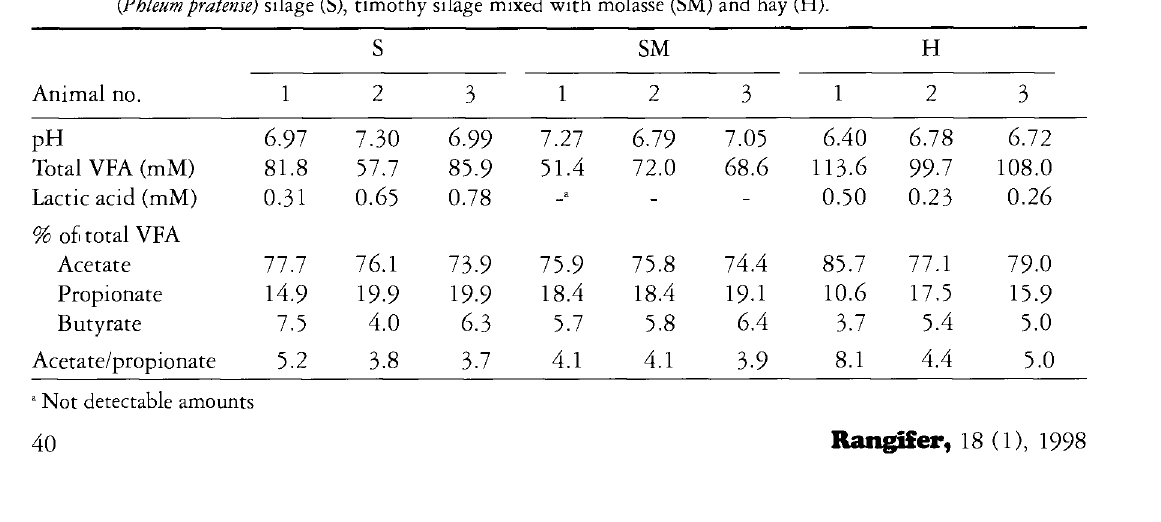
Table 3. Ruminal pH, concentration of volatile fatty acids (VFA) and lactic acid, and the relative proportion (%) of acetate, propionate and butyrate, and the acetate/propionate ratio in reindeer offered regrowth timothy (Phleum pratense) silage (S), timothy silage mixed with molasse (SM) and hay (H).